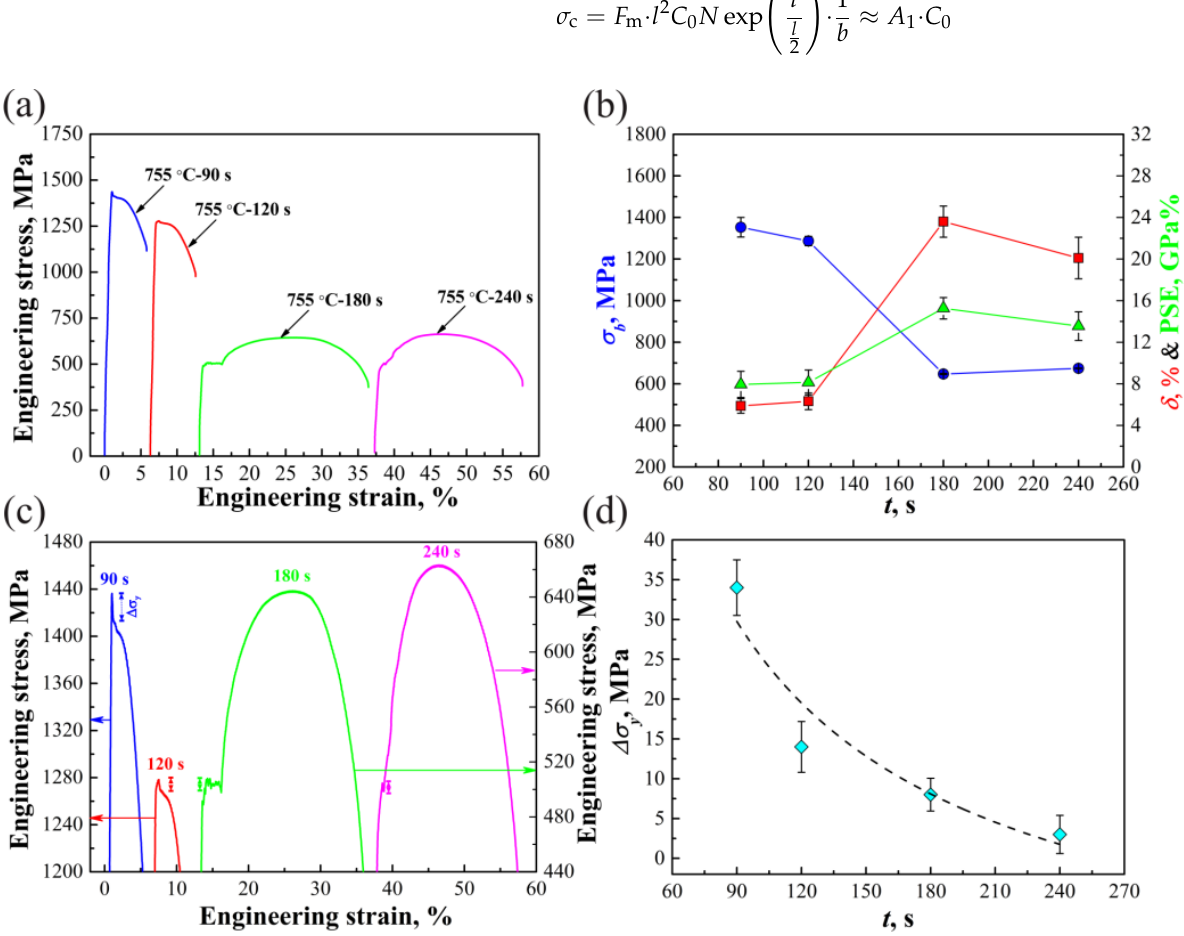
Figure 5. ( a ) Tensile engineering stress-strain curves; ( b ) variations of σ b , δ and PSE with t ; ( c ) magnified upper parts of tensile curves; ( d ) relationship between ∆ σ y and t .